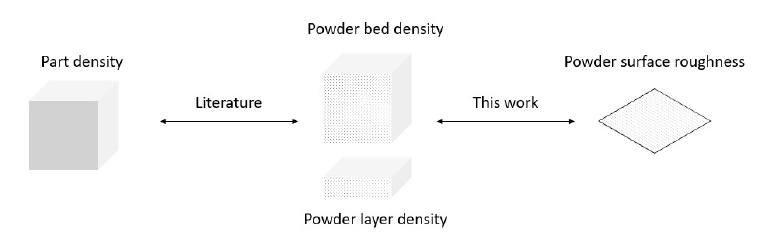
Figure 2. Correlation